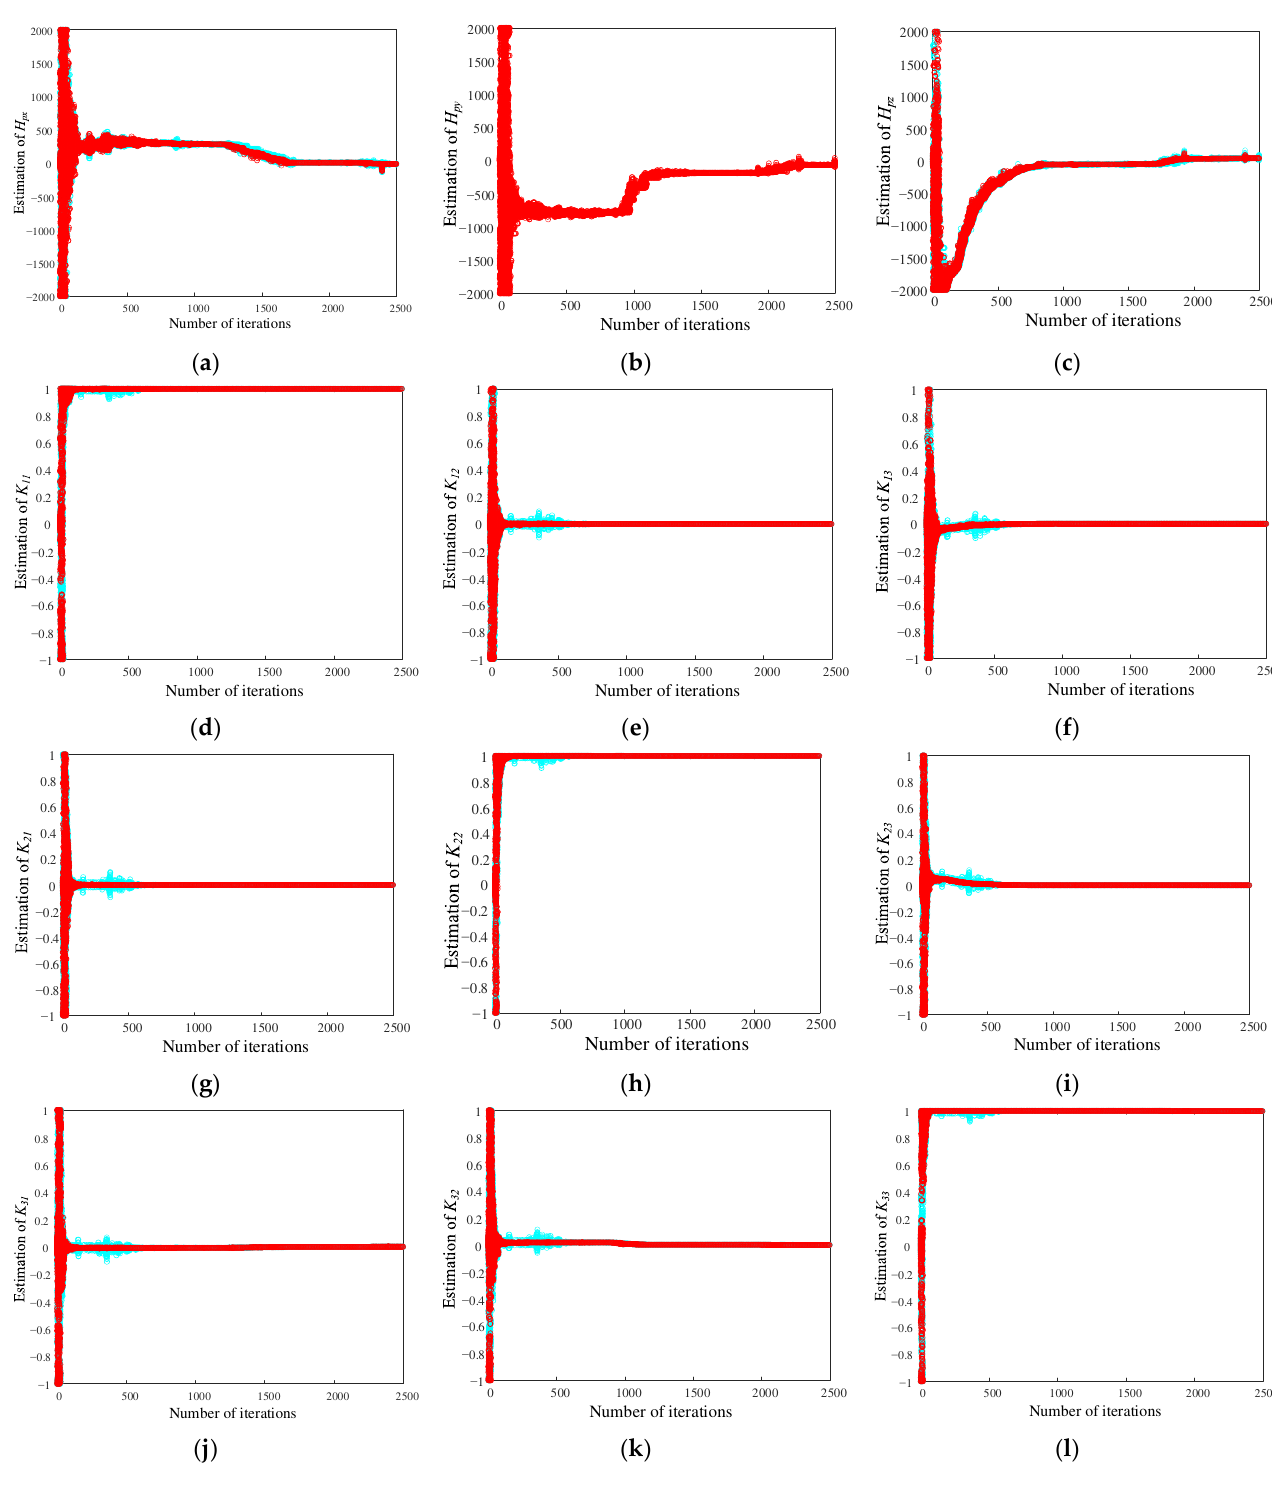
Figure 7. The searching process of compensation parameters: ( a ) the searching process of H px ; ( b ) the searching process of H py ; ( c ) the searching process of H pz ; ( d ) the searching process of K 11 ; ( e ) the searching process of K 12 ; ( f ) the searching process of K 13 ; ( g ) the searching process of K 21 ; ( h ) the searching process of K 22 ; ( i ) the searching process of K 23 ; ( j ) the searching process of K 31 ; ( k ) the searching process of K 32 ; ( l ) the searching process of K 33 .